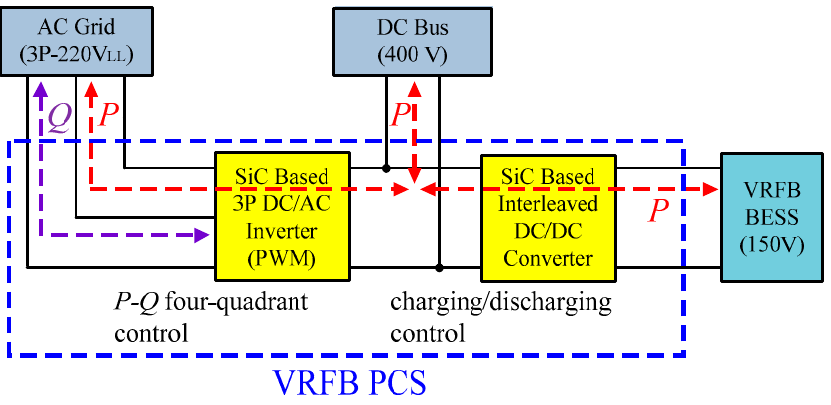
Figure 3. Possible active and reactive power flows in the proposed VRFB PCS.